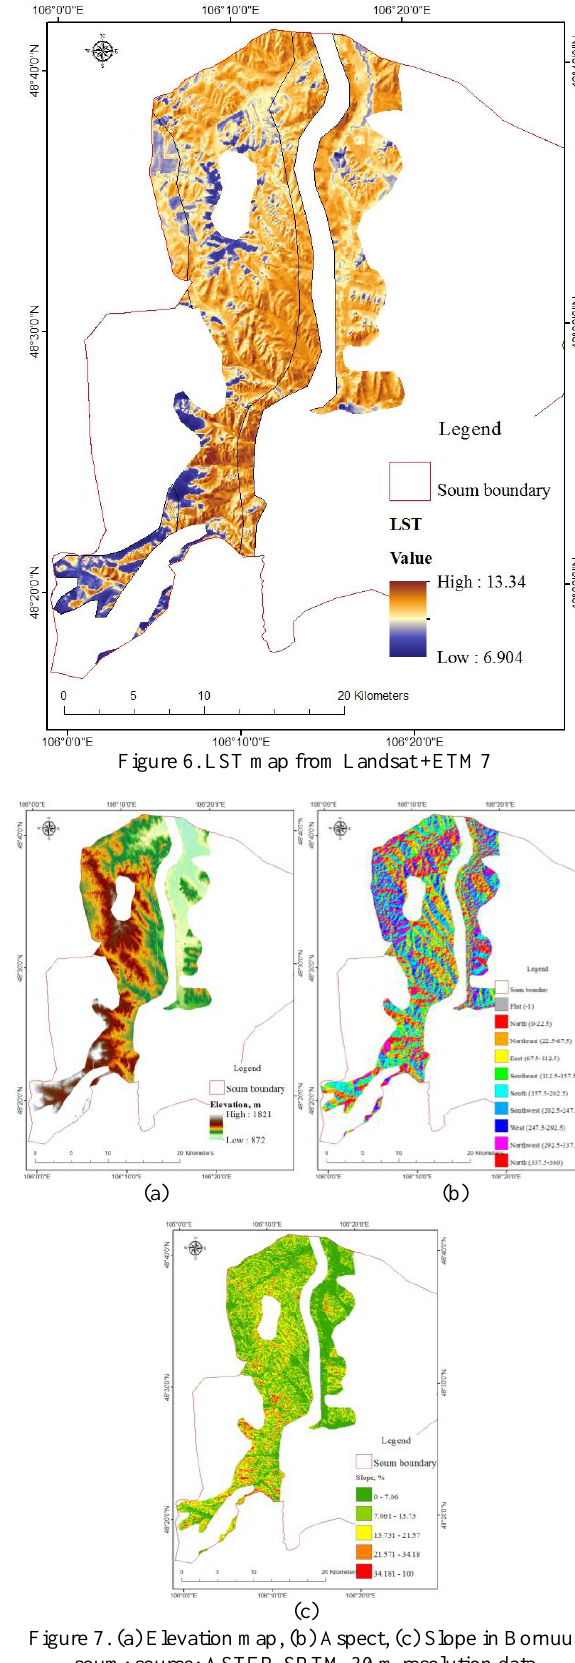
Figure 7. (a) Elevation map, (b) Aspect, (c) Slope in Bornuur soum; source: ASTER-SRTM 30 m resolution